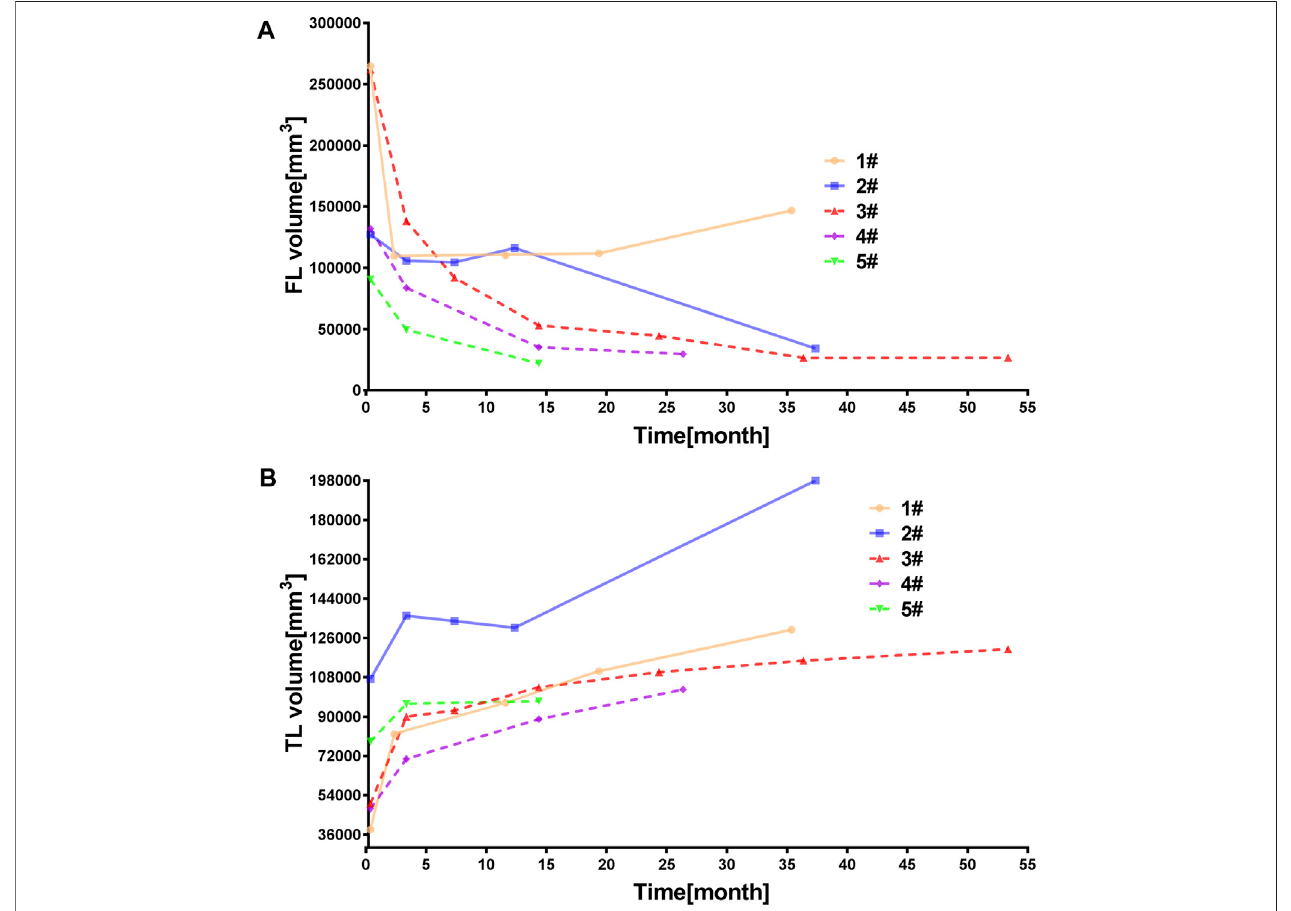
FIGURE 2 | (A – B) Variation of the false and true lumen volume changes during